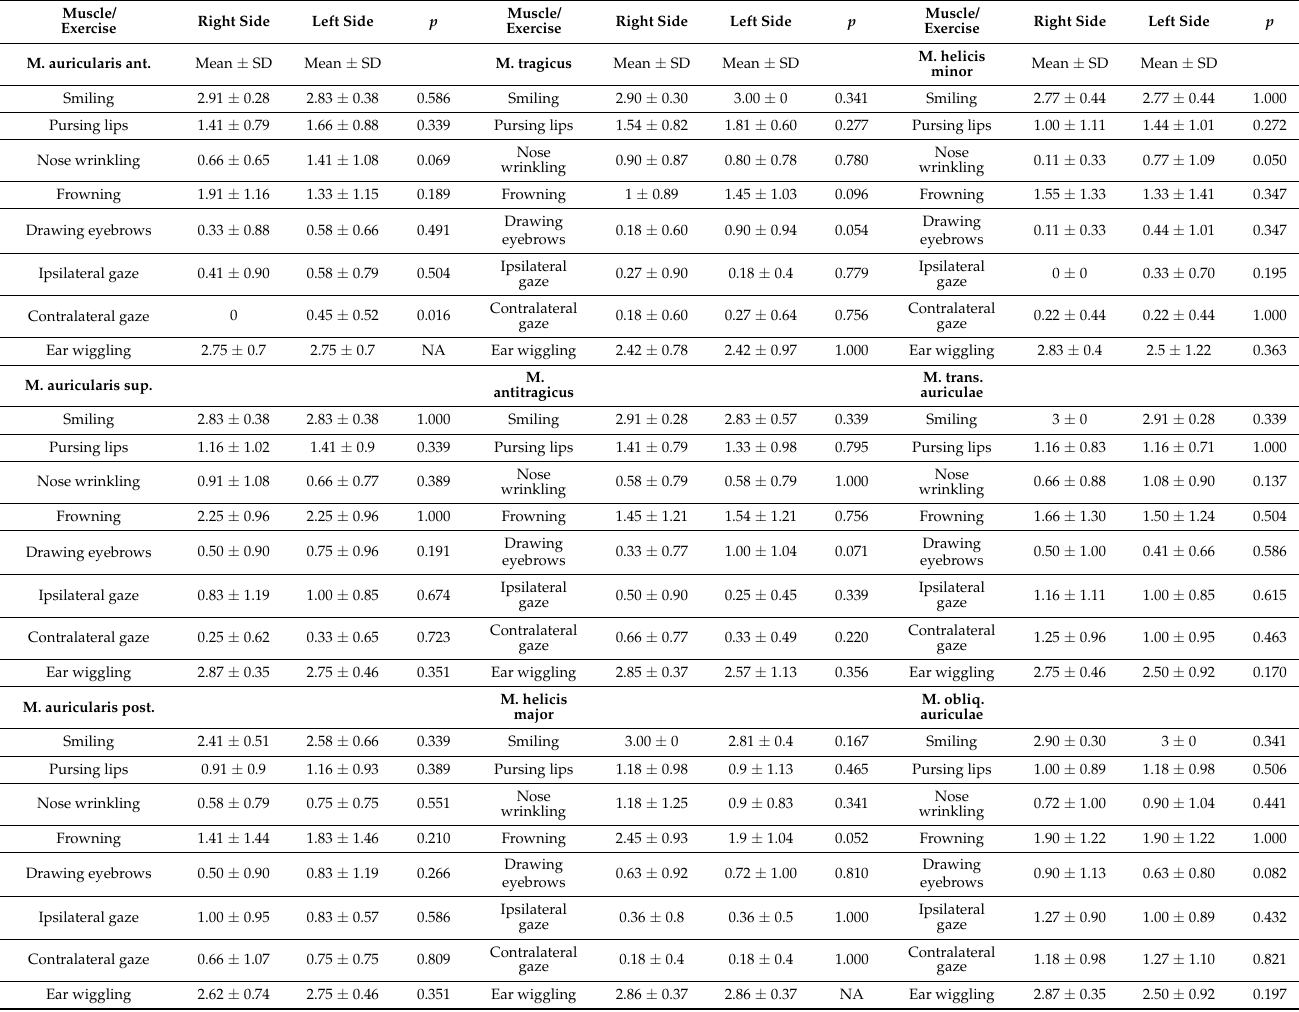
Table 1. Healthy probands: average surface single-channel EMG activity * in the different ear muscles during mimic tasks on right and left